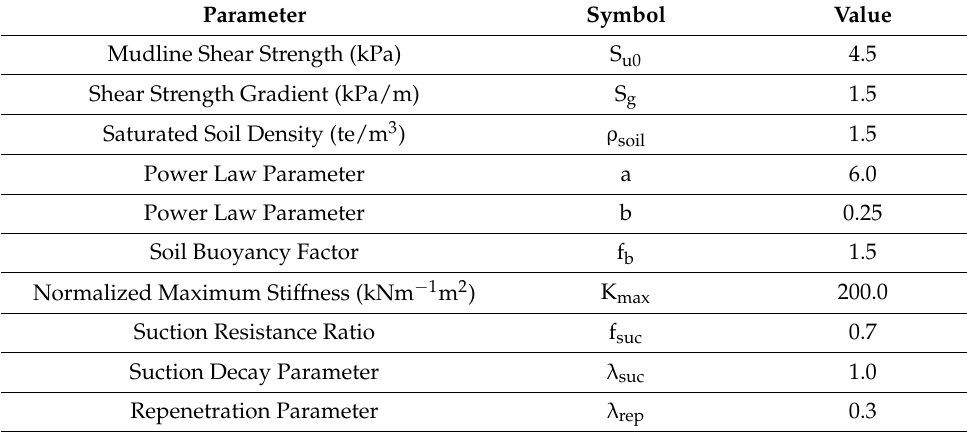
Table 5. Non-linear Soil Model parameters.